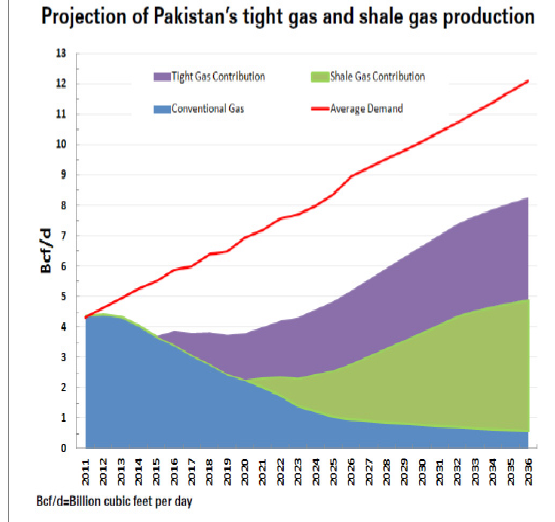
Fig. 3: Status of Tight Gas and Shale Gas Projected Production along with Production from Conventional Gas Reserves of Pakistan [16] The Zarghun South gas field operated by Jura Energy Corporation discovered and declared it as a tight gas field was another recent past success [28,30]. The field was declared as tight gas field following the guideline provided by Pakistan’s Tight Gas (E&P) Policy, 2011.